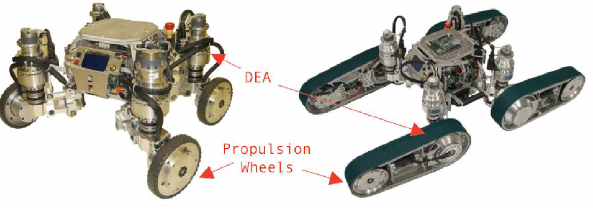
Figure 2. AZIMUT-3 in its wheeled configuration (left) and its tracked configu- ration (right).